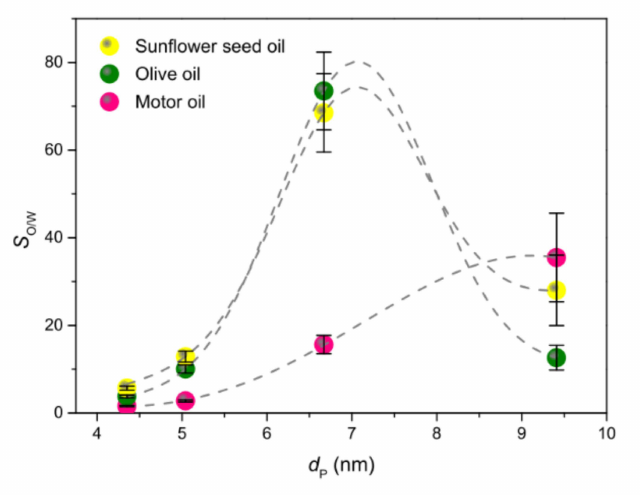
Figure 10. Oil/water selectivity ( S O/W ) as function of the average pore size ( d P ). Lines are drawn to guide the